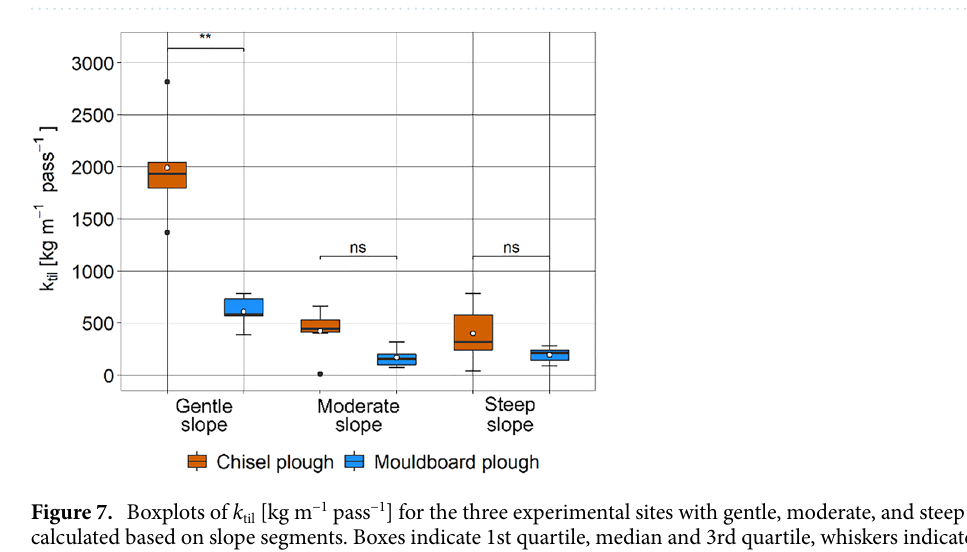
Figure 6. Boxplot of the RFID translocation distance per pass [m] for the three experimental sites with gentle, moderate, and steep slope. Comparison of the tillage implements ( a ) chisel plough and ( b ) mouldboard plough as well as down-slope (orange), up-slope (blue), and net translocation (green) of the RFIDs. Boxes indicate 1st quartile, median and 3rd quartile, whiskers indicate ± 1.5 times the inter-quartile range, while dots represent data beyond the end of the whiskers. White circles indicate mean values per boxplot. Stars denote significance levels of the Wilcoxon rank sum test for difference in means (ns: p-value > 0.05, *: p value < 0.05, **: p value < 0.01, ***: p value < 0.001).